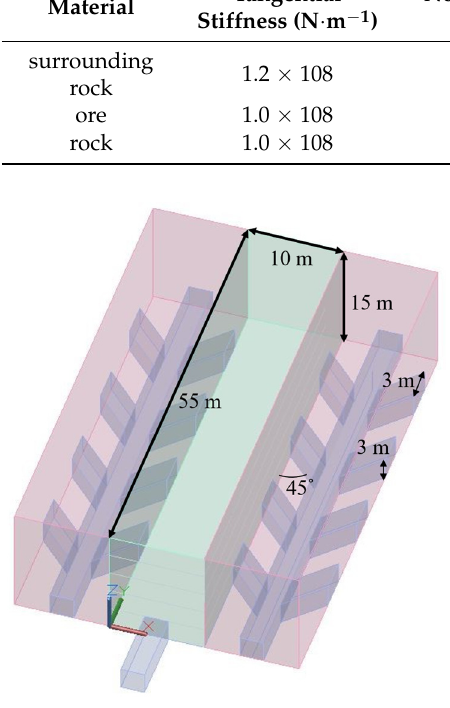
Figure 13. Drawing of ore drawing model.